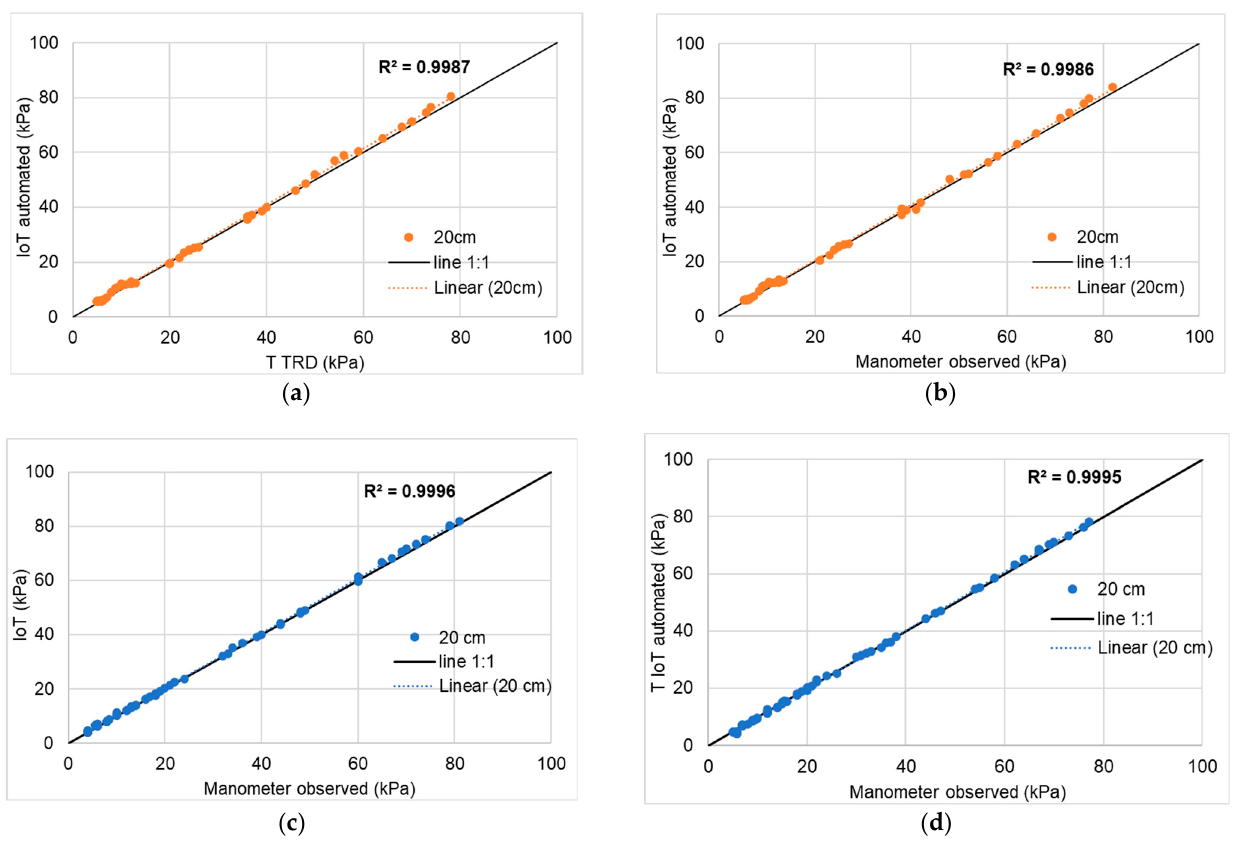
Figure 6. Comparison between the measured (observed) data and the automated feed: ( a ) and ( b ) First MCU node; ( c ) and ( d ) second MCU node.